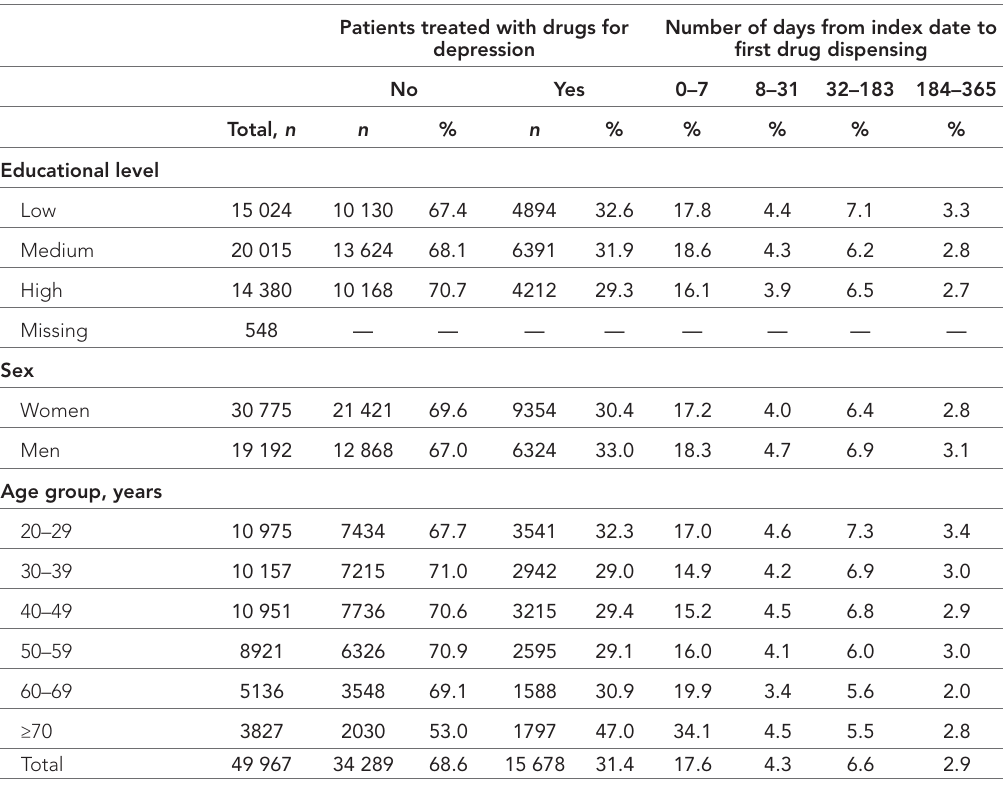
Table 1 Drug treatment for patients with a new depression diagnosis in 2015, and time from date of diagnosis to first drug dispensing, by education, sex, and age Patients treated with drugs for Number of days from index date to depression first drug